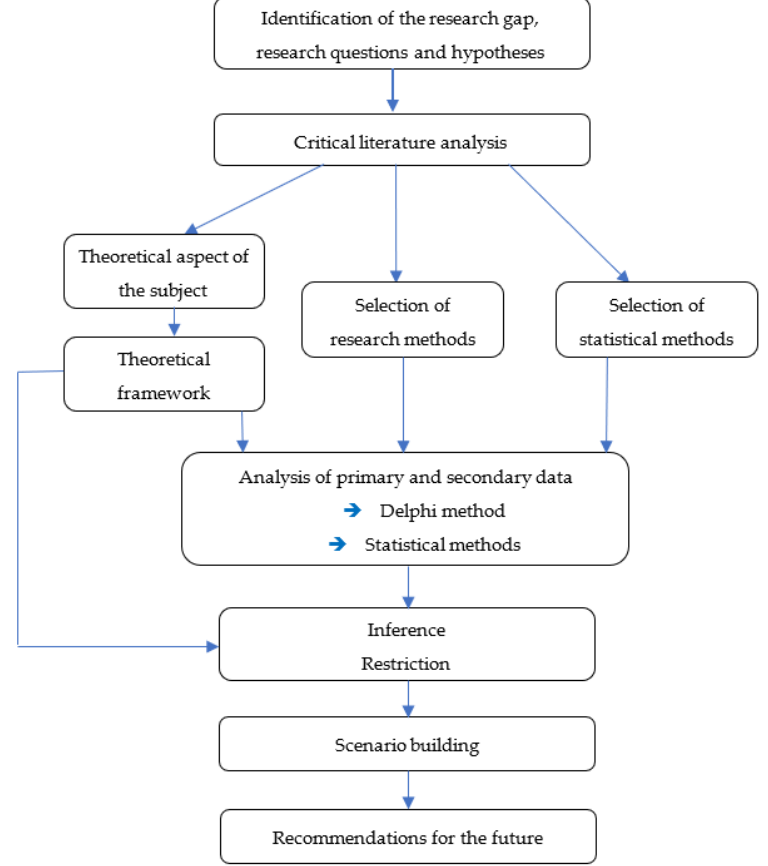
Figure 1. The flow chart of the methodology. Source: own elaborations.